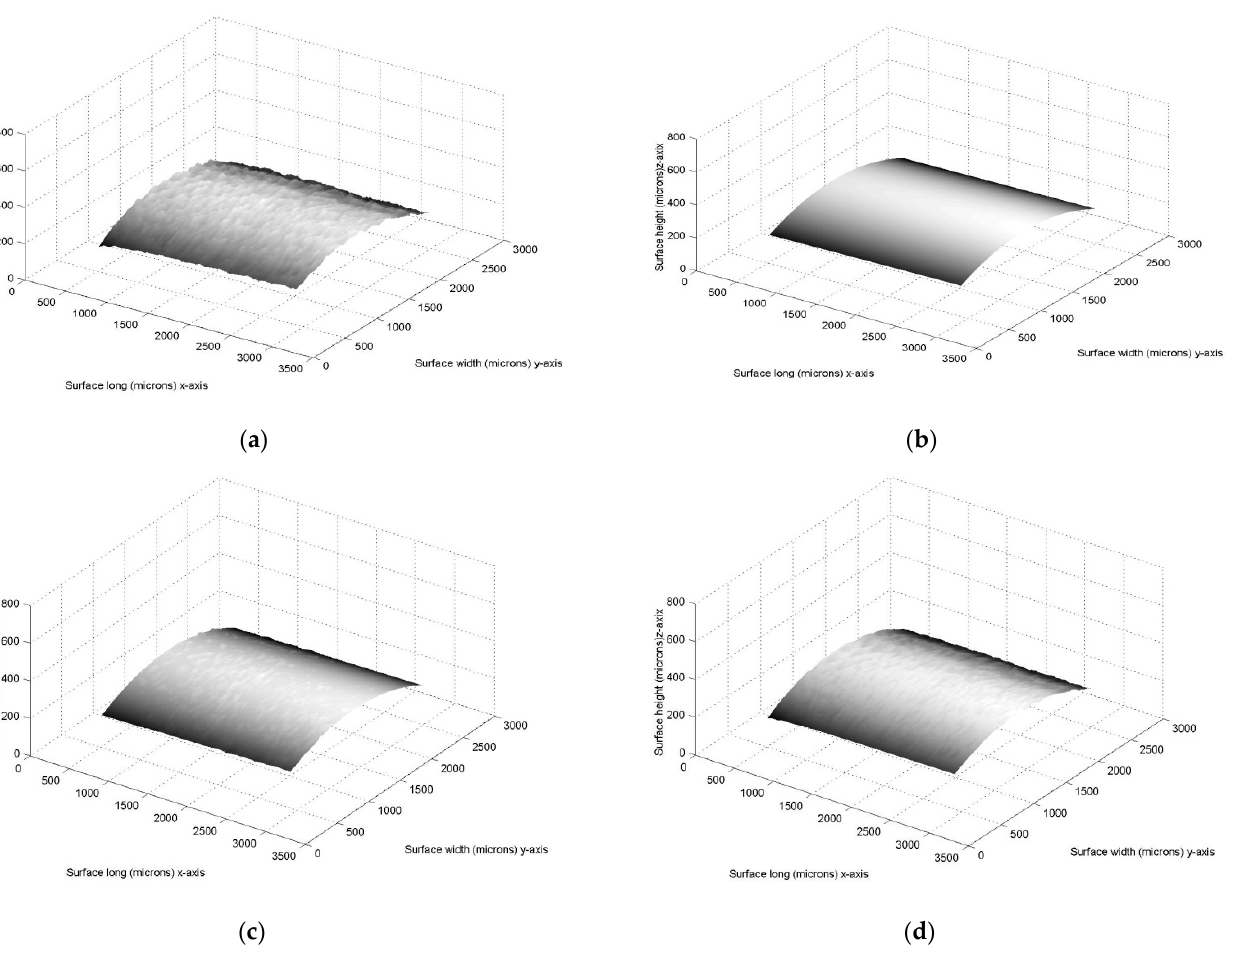
Figure 9. ( a ) Rectangular cylindrical surface to perform cylindrical surface modeling. ( b ) Micro laser line projected on the cylindrical surface to retrieve the surface topography. ( c ) Surface generated via cylindrical surface model and the surface data over the surface model. ( d ) Surface generated via cylindrical surface model and the surface data under the surface model.